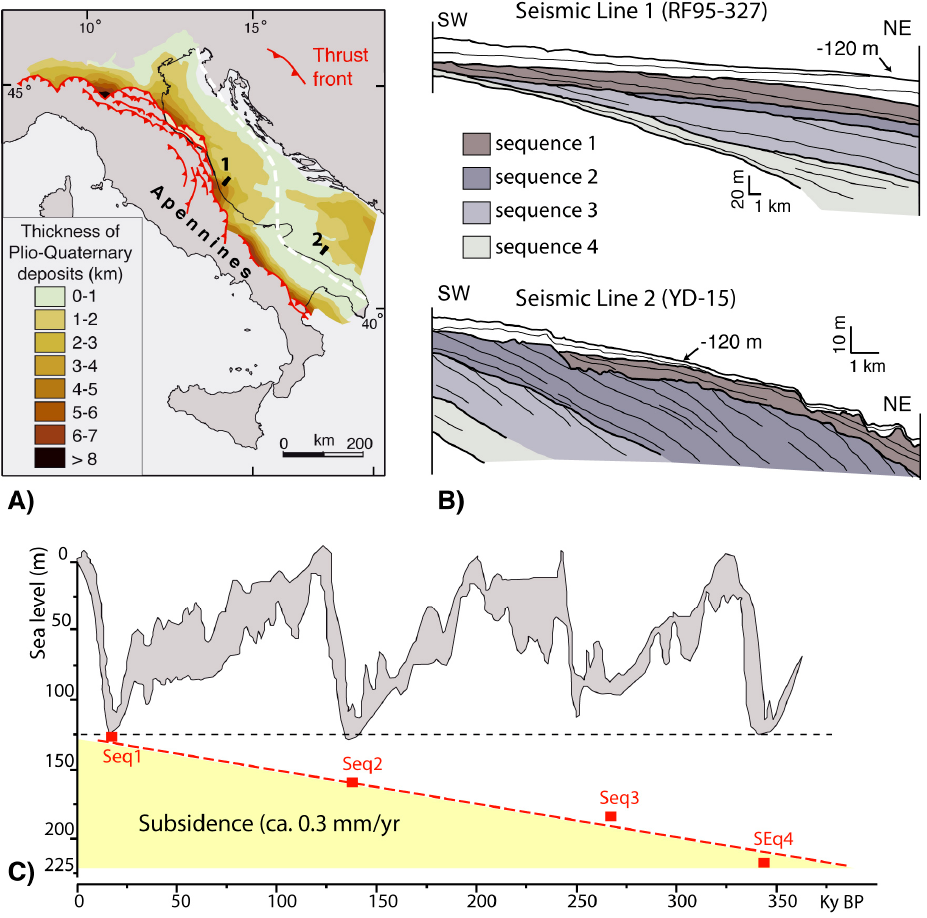
Figure 2. ( A ) (modified from [46]): The Adriatic Sea is part of the Apennine foreland basin, where sectors affected by greater subsidence were filled by foredeep deposits since the Pliocene. The depocenters of these foredeep deposits thin towards the flexural bulge (white dashed line), evidencing areas with contrasting rates of tectonic subsidence (greater along the North-Central Adriatic shelf) and uplift (greater along the South Adriatic shelf). ( B ) These regional tectonic trends are reflected by the vertical stacking pattern of depositional sequences recording ca. 100 ky glacio-eustatic cycles: sequences display a back-stepping geometry (i.e., landward shift) from oldest sequence 4 to sequence 1 in the Central Adriatic (Line 1). In contrast, the sequences show a fore-stepping trend in the South Adriatic, where lower subsidence and/or uplift prevail during the same interval [44, 48]. ( C ) (Modified from [54]): Average subsidence rates of 0.3 mm/y in the Central Adriatic have been derived by comparing the depth of lowstand shorelines for each sequence (red rectangle) with sea level curves (enveloped as a grey field) reconstructed by different authors [61–65]. This value is twice the average sediment supply estimated for the same interval [54], thus allowing for a renewal of accommodation space during each cycle and promoting the back-stepping of sequences.